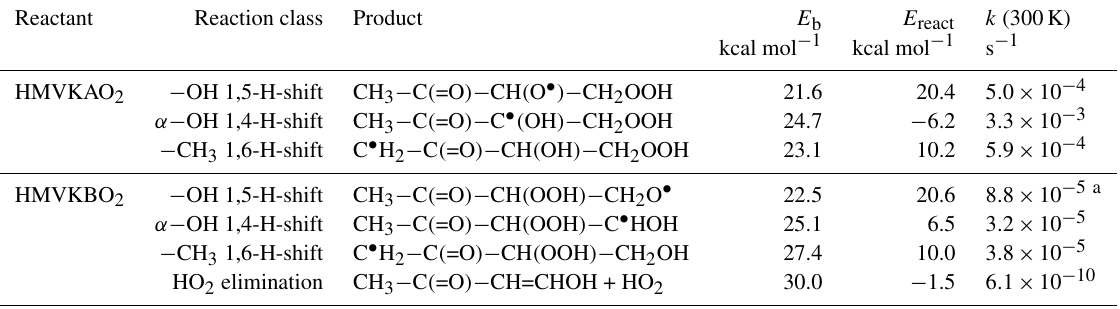
Table 2. H-migration and HO 2 elimination in hydroxy − MVK − peroxy radicals. Barrier height E b , reaction energy E react and the rate coefficient k at a temperature of 300K are listed. Arrhenius expressions for a temperature range between 200 and 400K are available in the Supplement.